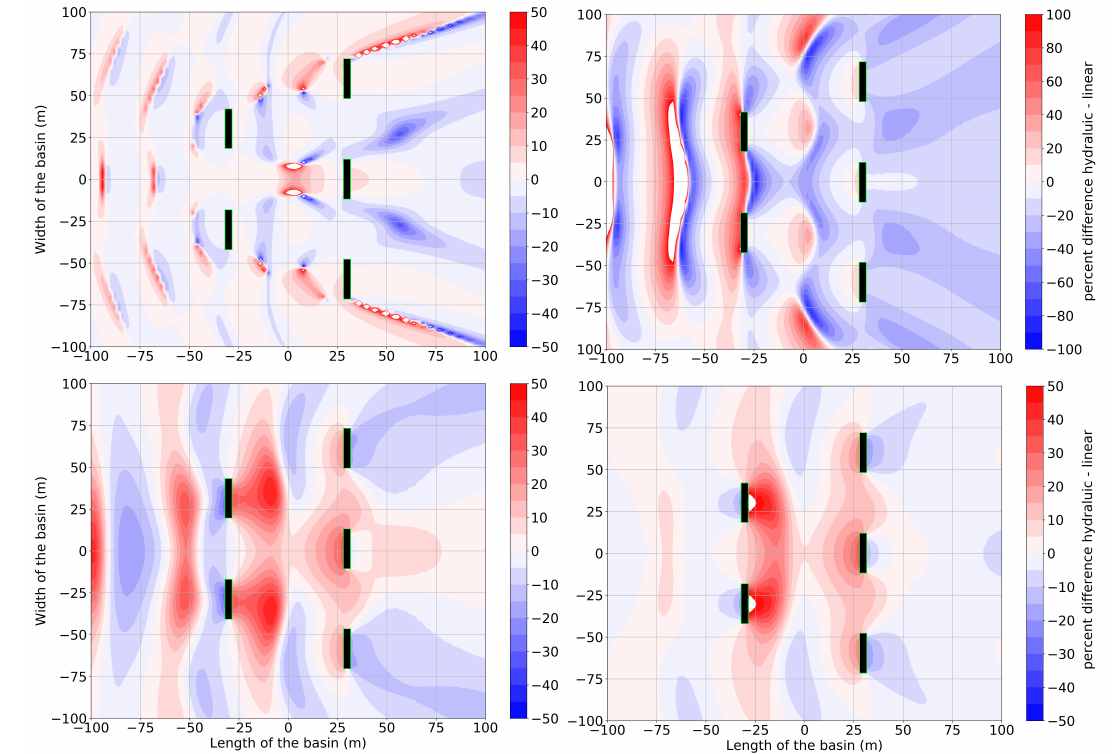
Figure 22. Percentage difference between the | η | produced by an OSWEC with a hydraulic PTO vs. a linear PTO system for a wave of H = 1.0 m and wave periods of T = 6.0 s ( top left ) T = 8.0 s ( top right ) T = 10.0 s ( bottom left ) T = 12.0 s ( bottom right ). Incident wave propagating from the